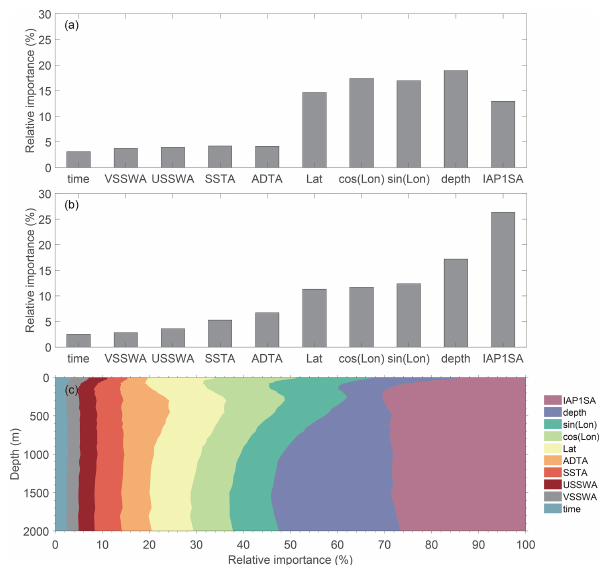
Figure 16. A quantification of the relative importance of each in- put in reconstruction of IAP0.25 ◦ : (a) at the surface, (b) 1–2000m average, and (c) at each depth from 1 to 2000m. The input features are ranked in terms of importance; i.e., the higher the SHAP value is, the more important the features